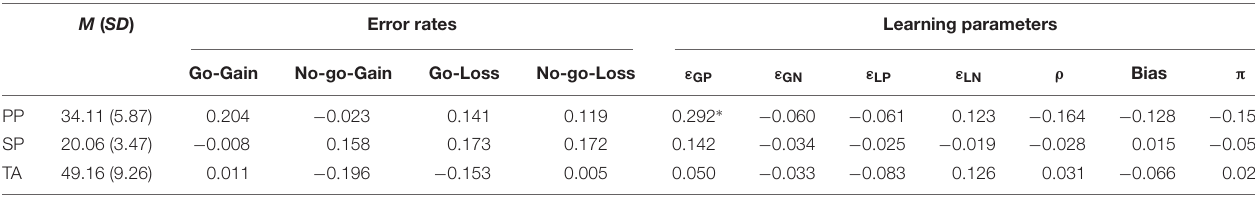
TABLE 2 | Descriptive statistics and correlations of each personality trait with task performance and learning parameters. M ( SD ) Error